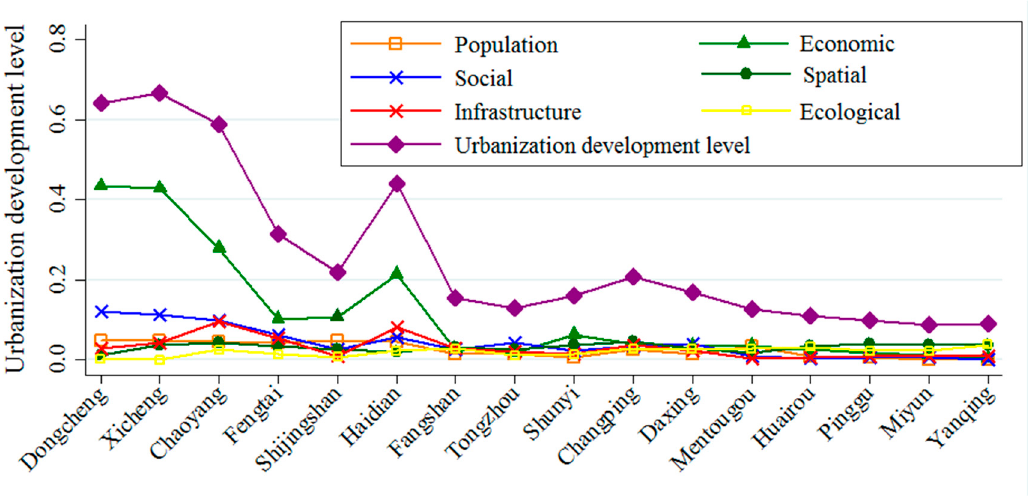
Figure 2. Distribution of urbanization development level across different regions.